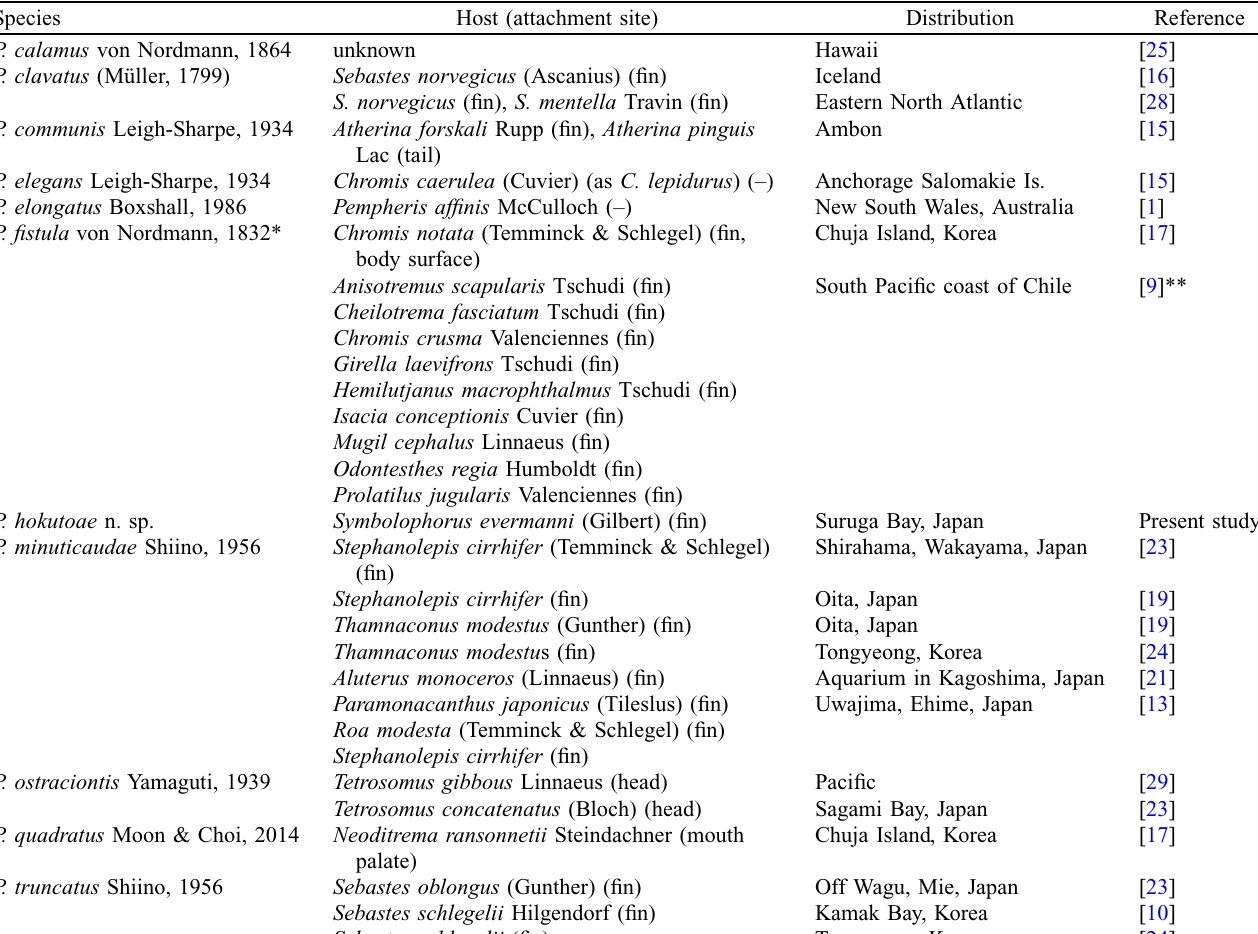
Table 1. Host, attachment site and distribution of Peniculus . –: no data.